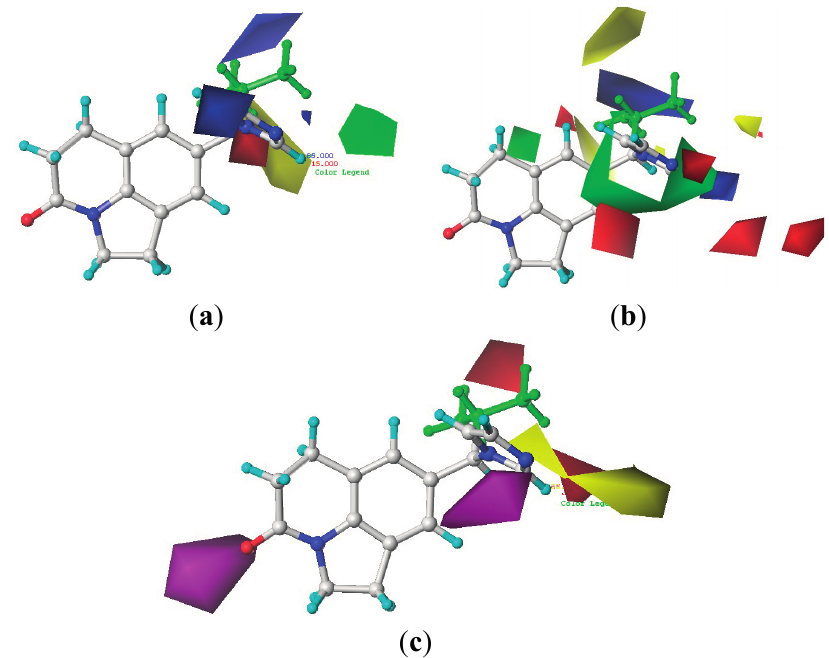
Figure 4. CoMFA and CoMSIA contour maps displayed using the most potent compound 26 . ( a ) CoMFA steric and electrostatic contour map (green indicates favored, yellow indicates disfavored, blue indicate favoreds, red indicates disfavored); ( b ) CoMSIA steric and electrostatic contour map (green indicates favored, yellow indicates disfavored, blue indicates favored, red indicates disfavored); ( c ) CoMSIA hydrophobic and acceptor contour map (yellow indicates favored, white indicates disfavored, magenta indicates favored, red indicates